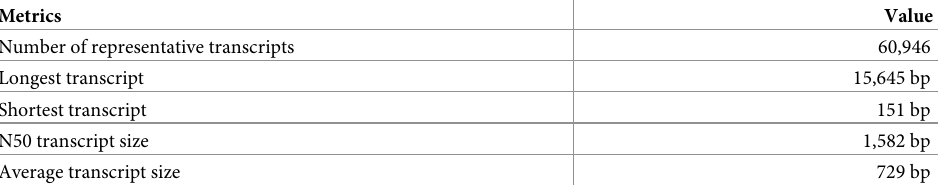
Table 2. Metrics of the representative transcriptome of sweet cherry ( Prunus avium L. ’Tieton’).